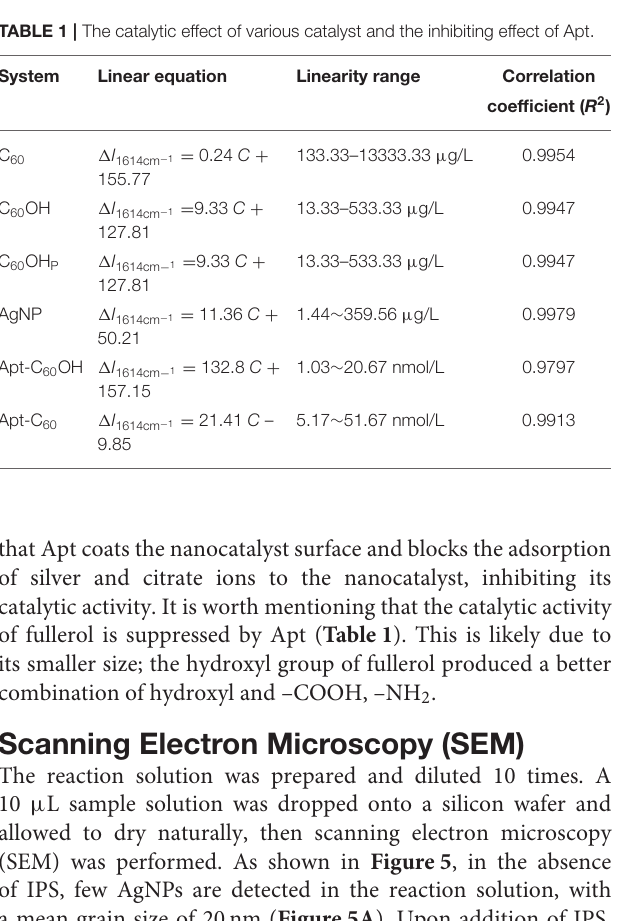
Table 2 . SERS exhibited the best performance, with a maximum slope of 492.83, and a limit of detection of 8.2 ng/L;